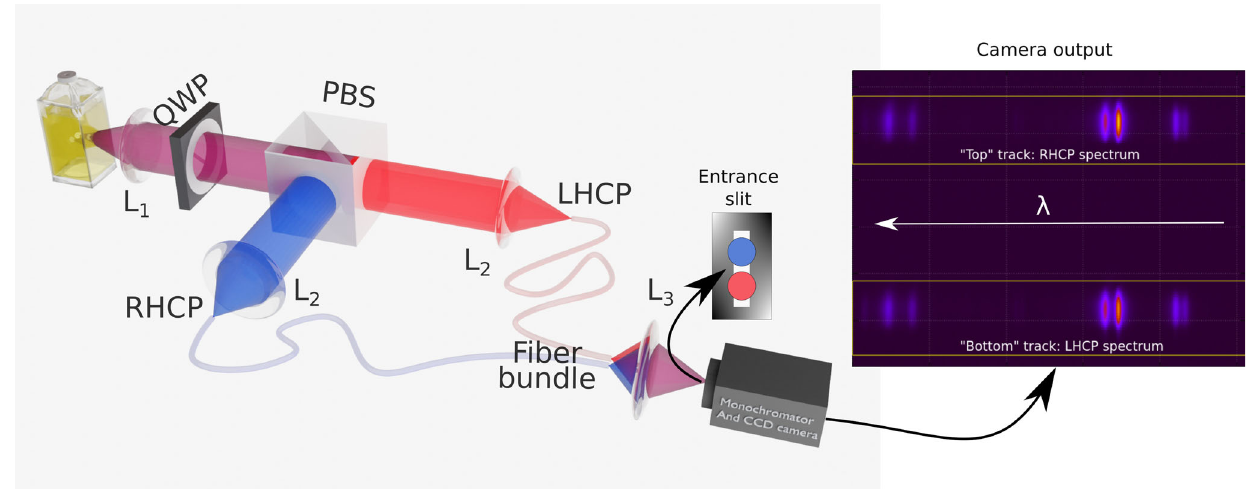
two vertically separated spots on the entrance slit of the monochromator (see SI, Sec 1). The two spots are horizontally diffracted by the grating giving on the CCD camera the top/bottom spectrum coming from the top/bottom spots and thus related to the LHCP and RHCP emission. Here, the image is recorded from a Eu 3+ complex 2